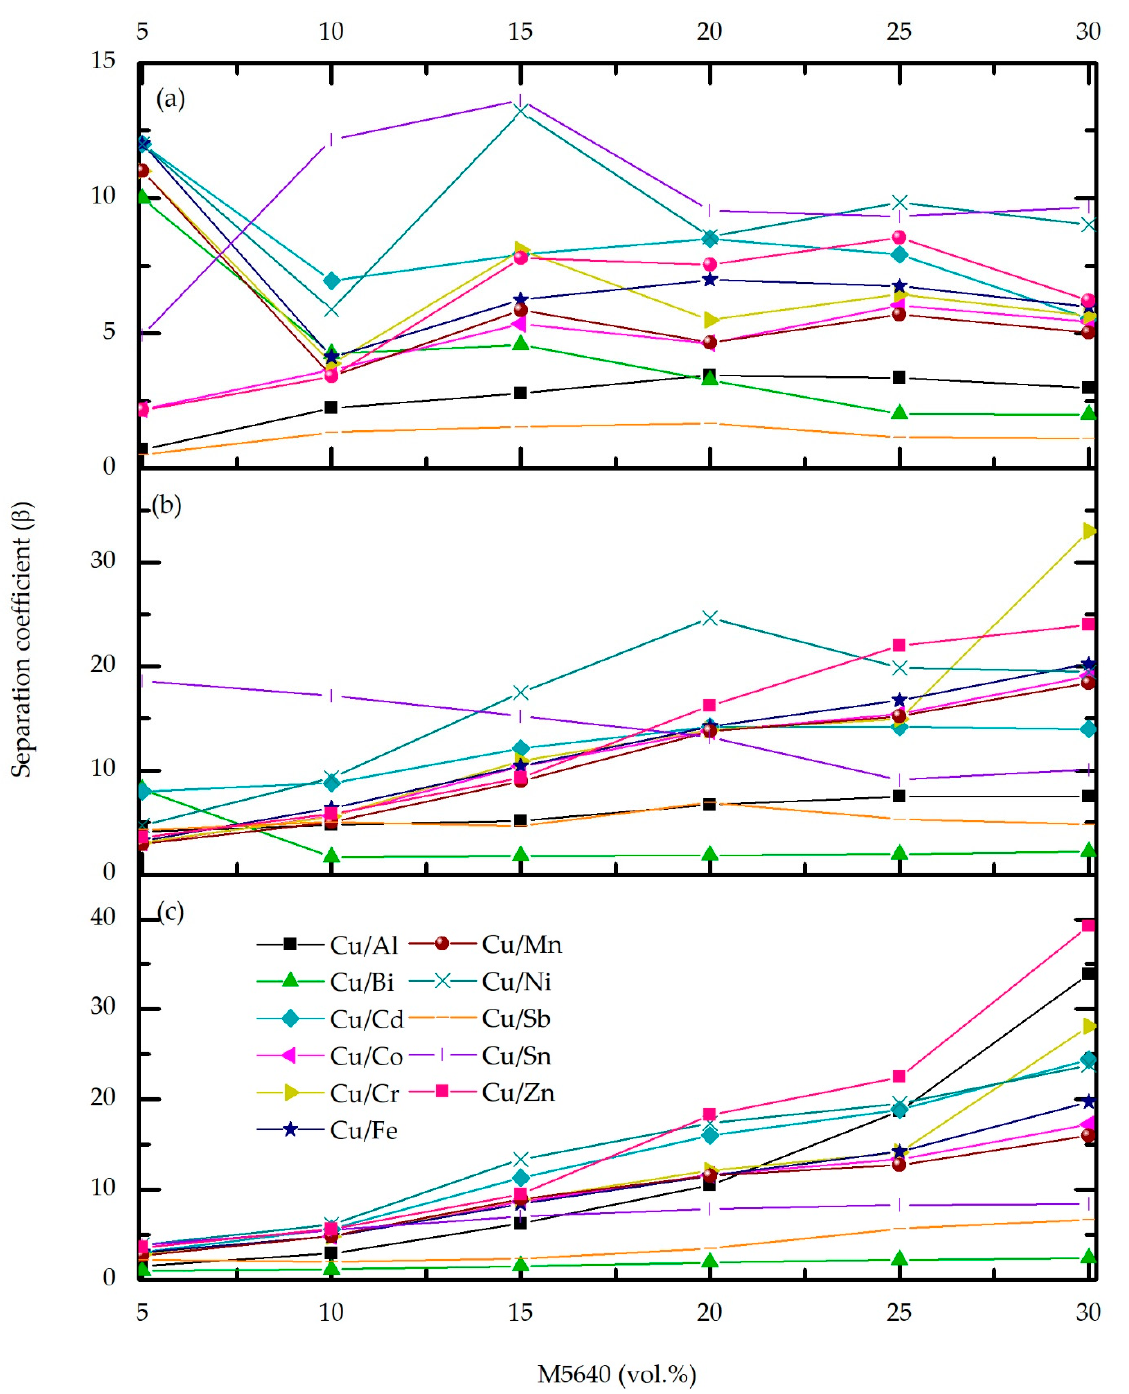
Figure 3. Effect of M5640 concentration and O/A phase ratio 4 ( a ), 3 ( b ), and 2 ( c ) on Cu-metal separation factor for the feed pH 0, temperature 20 °C, and contact time 10 min.